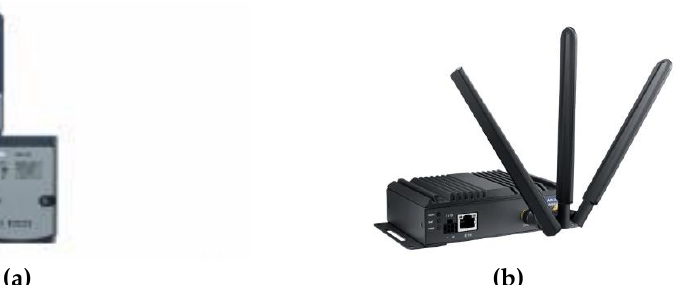
Figure 3. Pictures of the sensor node and hub listed as: (a) WISE-4610P sensor node; (b) WISE-6610- N100C-A hub [66].